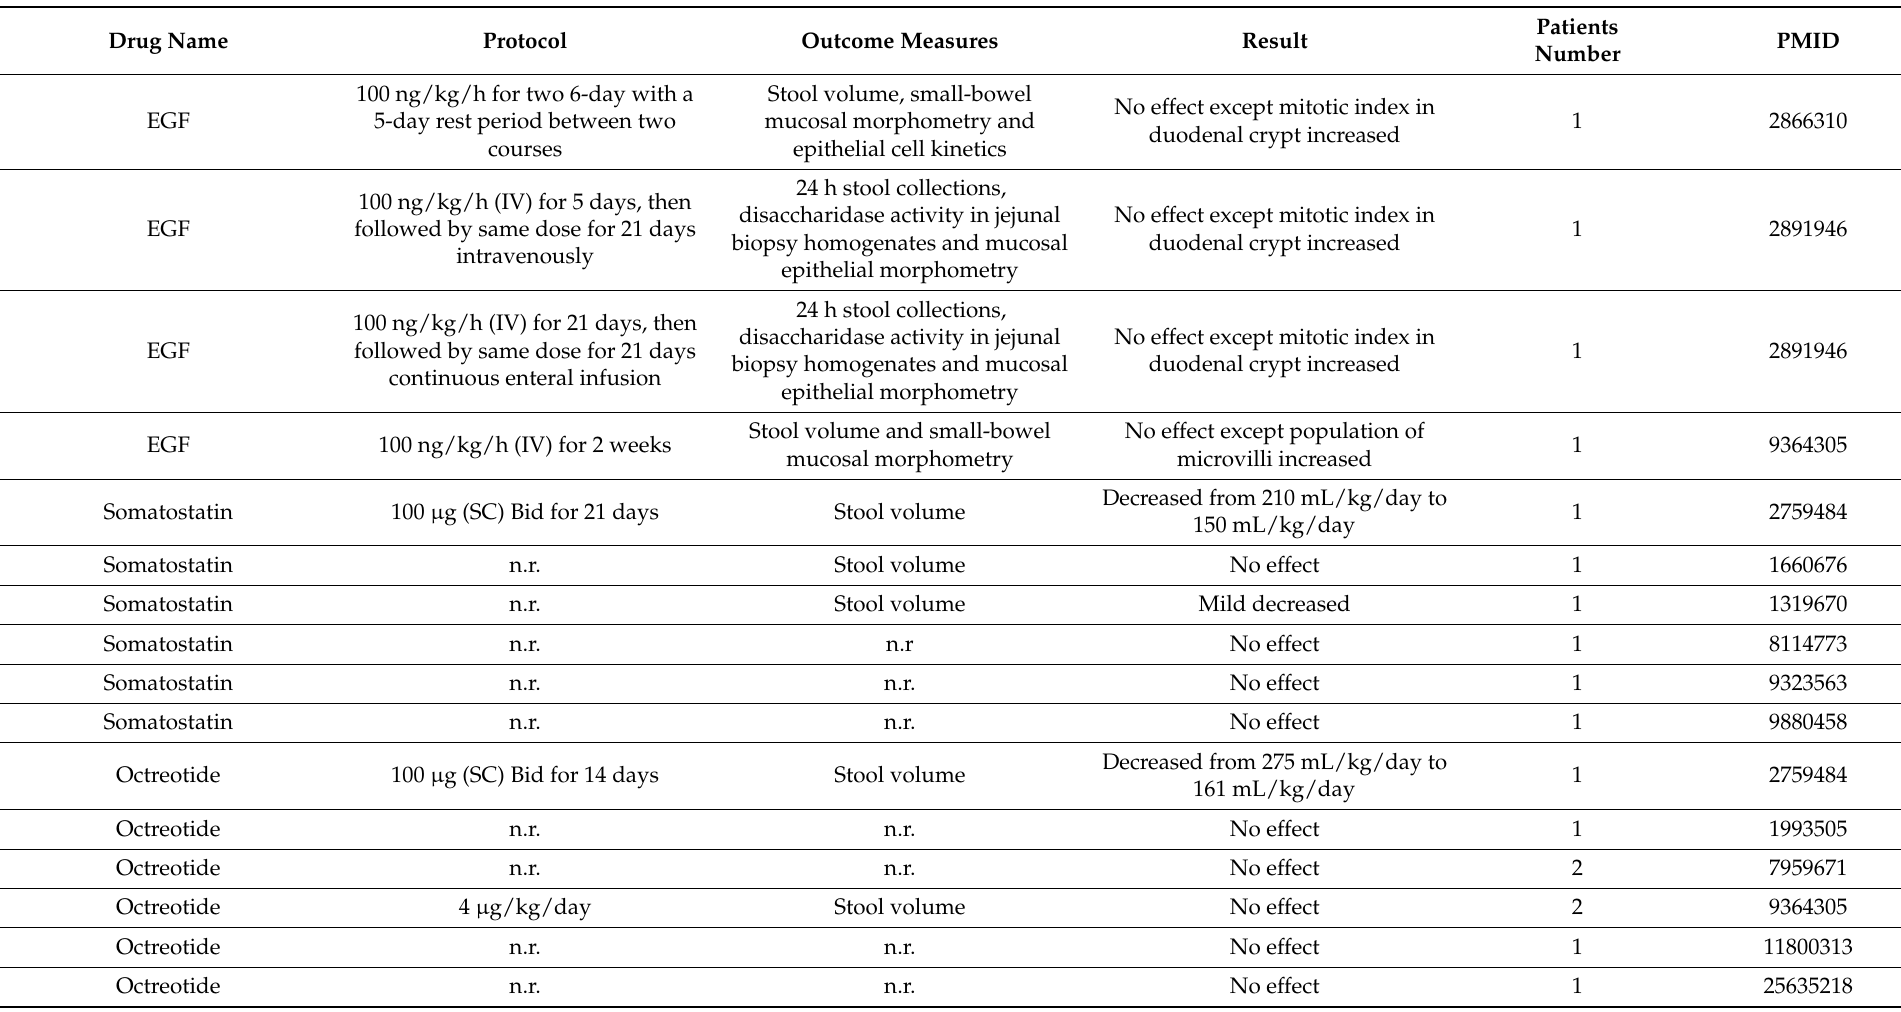
Table 3. A list of patients who were treated with pharmacological interventions (retrieved from Table S1). This yielded 15 unique articles reporting a total of 35 patient treatments involving 8 different pharmacological interventions. IV: intravenous injection; SC: subcutaneous injection; Bid: two times per day; Tid: three times per day; Qid: four times per day; n.r.: not